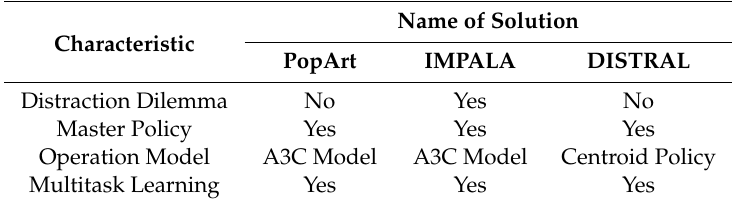
Table 1. Comparison of existing